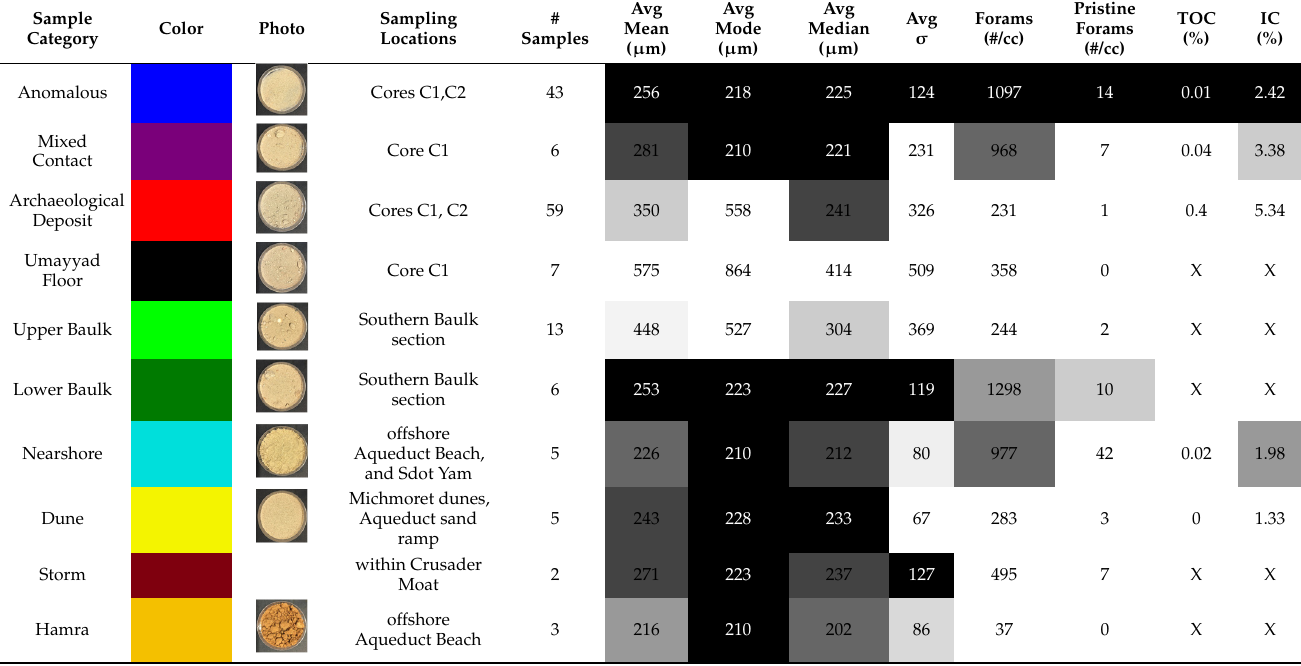
Table 1. Overall Comparison Table. Table comparing the anomalous sediment characteristics to each reference sediment type. For each parameter, sample values for each sediment type have been averaged. The anomalous samples are all shaded in black. For all reference sediments, the box for each parameter is shaded based on how distant (by %) it is from the anomalous sample values, which are shaded black. With each 5% difference away from the anomalous samples, the shading becomes lighter. White cells indicate a value that shares the least similarity while black or dark gray indicates closer similarity.